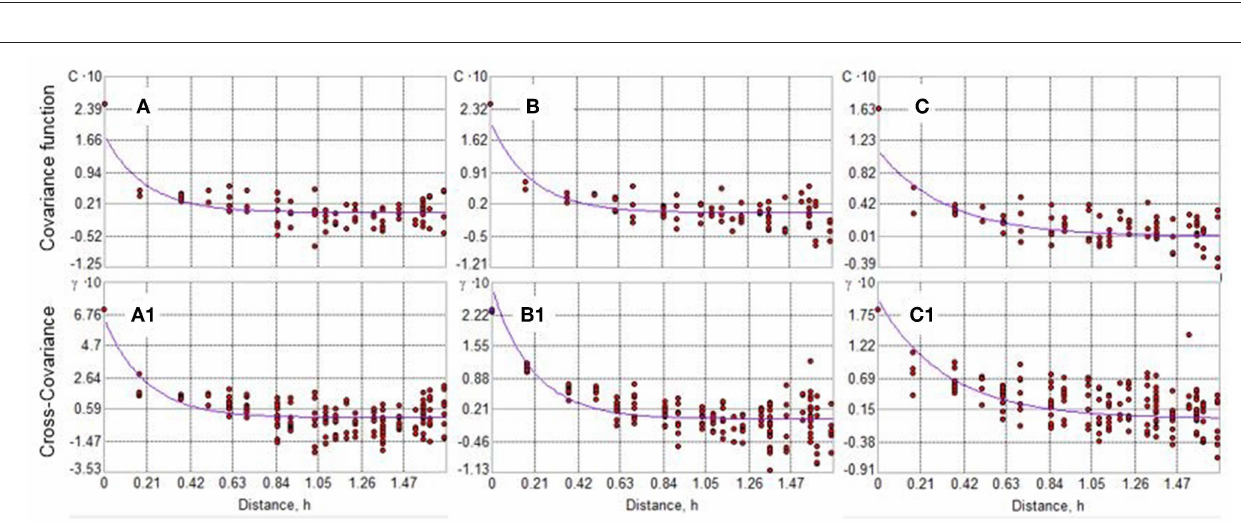
FIGURE 3 | Covariance function C X ( h ) at threshold z k (ED > 3 MJ ha − 1 h − 1 ) for (A) August, (B) September, and (C) October month, with respective model of co-regionalization between indicator and uniform transforms [cross-covariance CC XI ( h ; z k )], (a 1 ), (b 1 ), and (c 1